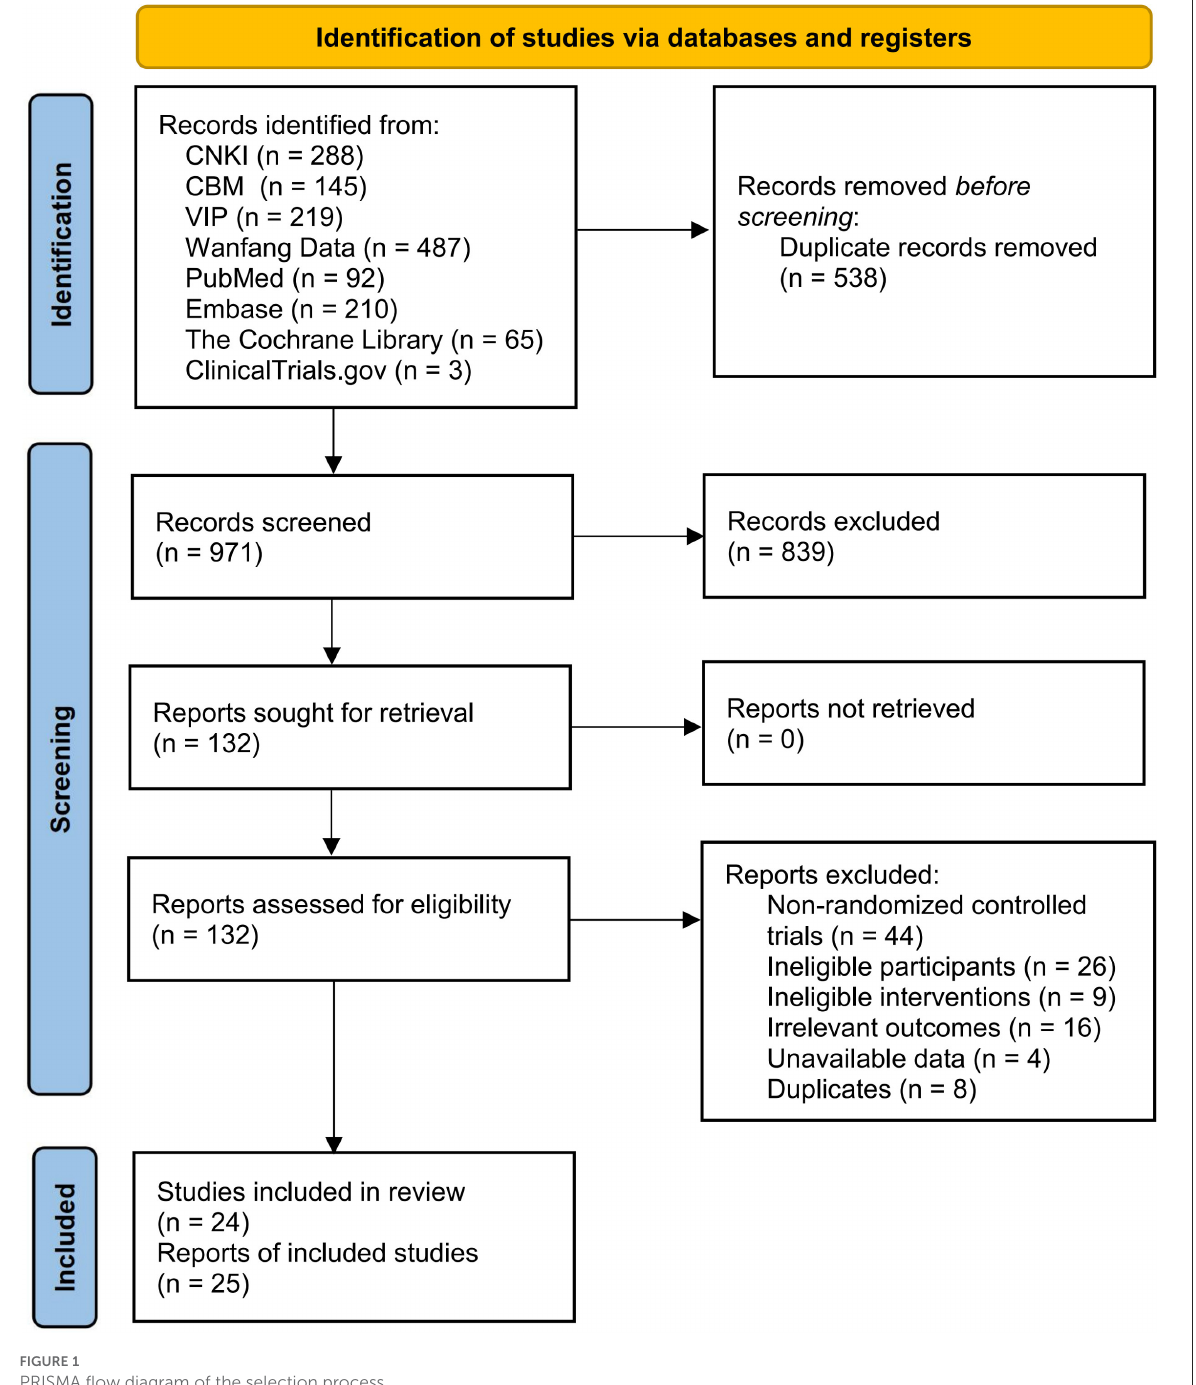
FIGURE1 PRISMA flow diagram of the selection